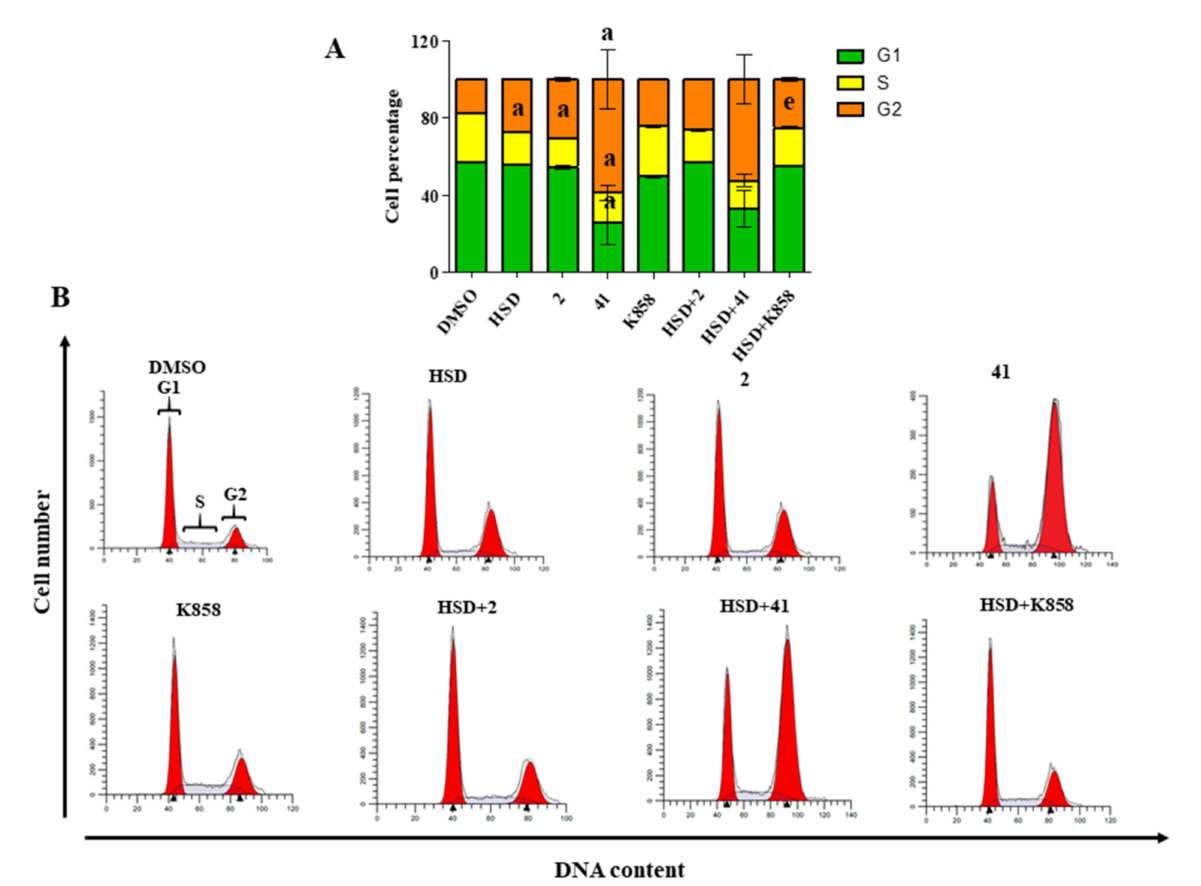
Figure 5. Cell cycle analysis in AGS cells treated with HSD (180 µ M), 2 (1 µ M), 41 (5 µ M), K858 (1 µ M), and a combination of HSD with Eg5 inhibitors for 48 h. Data shown are mean ± SD of three independent experiments. ( A ) The bar graph shows cell percentages in the phases of cell cycle (G1, S, and G2) of AGS. DMSO 0.5%: control vehicle. a = p < 0.0001 between Eg5 inhibitors alone and DMSO; e = p < 0.001 between K858 alone and HSD+ K858 combination. ( B ) Cell cycle profiles represented by fluorescence emission peaks obtained after propidium iodide staining ( y -axis = cell count; x -axis = propidium iodide fluorescence emission in the FL- channel directly proportional with DNA